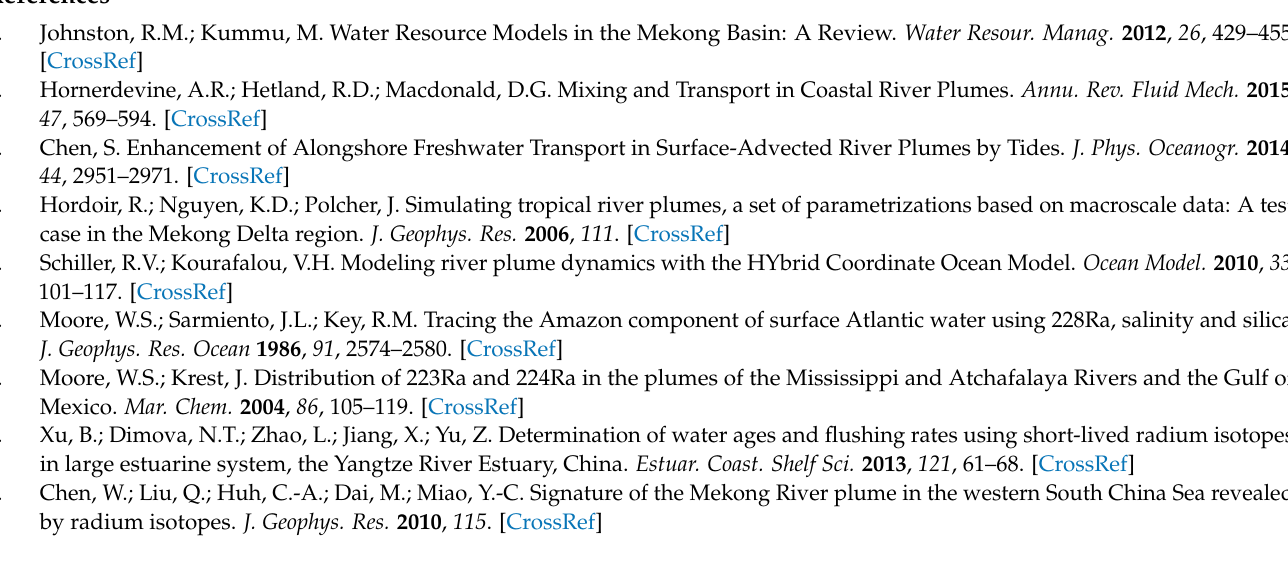
Figure A1. The variance in RMSE when the fitting period ranges from 1 year to 7 years.